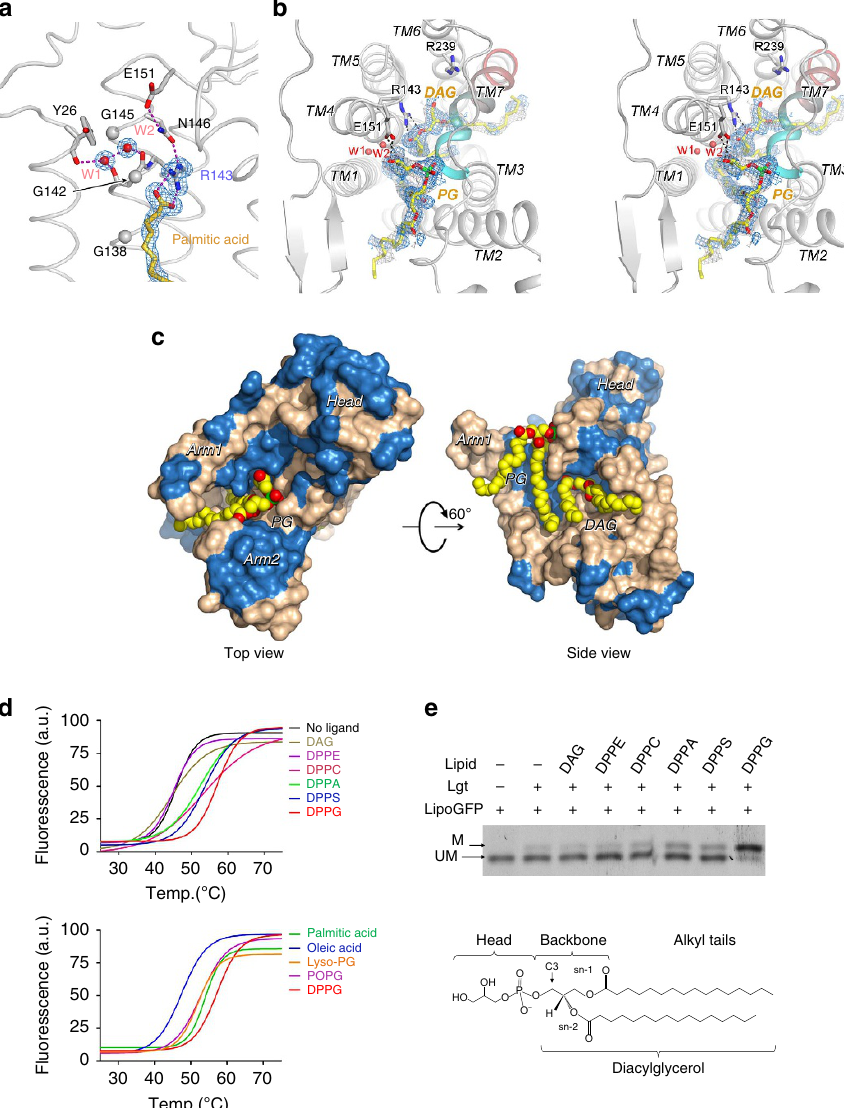
Figure 5 | Binding site of donor-substrate PG. ( a ) Binding of palmitic acid to R143 in the form-1 crystal structure. The 2 F o (cid:2) F c map contoured at 1.0 s is shown around R143, palmitic acid, and two nearby water molecules (W1 and W2). ( b ) Stereo view of binding of PG and DAG to the first and second PG-binding sites in the form-2 crystal structure. The F o (cid:2) F c omit map (2.0 s , blue) and 2 F o (cid:2) F c omit map (1.0 s , wheat colour) are shown around the ligands. TM7 is coloured from cyan at the N-terminal end to red at the C-terminal end. ( c ) PG binding. Lgt is shown in a molecular surface model, and PG and DAG are shown as a sphere model. Hydrophobic residues of Lgt are shown in wheat colour, and hydrophilic residues in blue. In the side view, the minor TM domain is removed for clarity. ( d ) Thermostability of Lgt in the presence of different lipids. Thermofluor data of (10 m M) WT Lgt in the presence of 100 m M of various lipids are fitted to a Boltzmann model. Chemical structures of the tested lipids (upper group) are shown in Supplementary Fig. 2a. The corresponding T m values (average ± s.d., in (cid:2) C) are: blank, 46.0 ± 0.2; DAG, 46 ± 2; DPPE, 46 ± 1; DPPC, 52 ± 1; DPPA, 53 ± 1; DPPS, 54 ± 0.5;